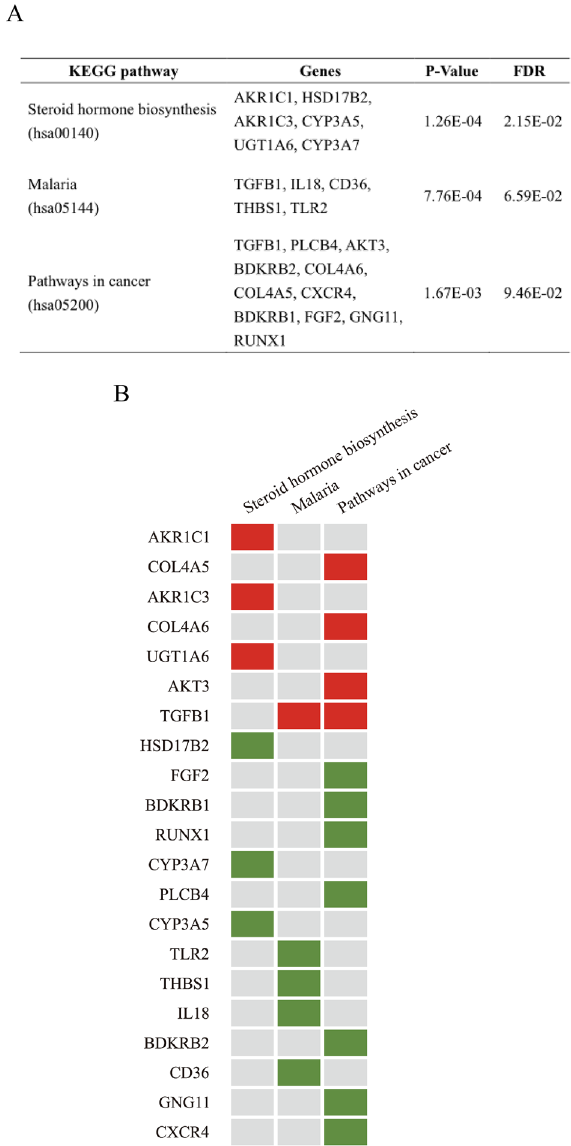
Figure 5. Enriched KEGG pathways. ( A ) List of significantly enriched KEGG pathways. ( B ) Hub genes that were enriched in KEGG pathways were considered key genes. Red indicates upregulated genes, and green indicates downregulated genes.